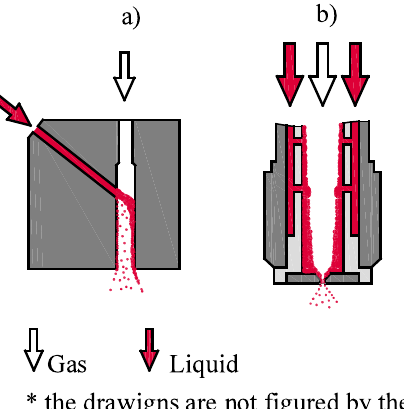
Figure 7. Internal two-phase flow patterns estimated for the Y-jet ( a ) and the OIL atomizer ( b ).